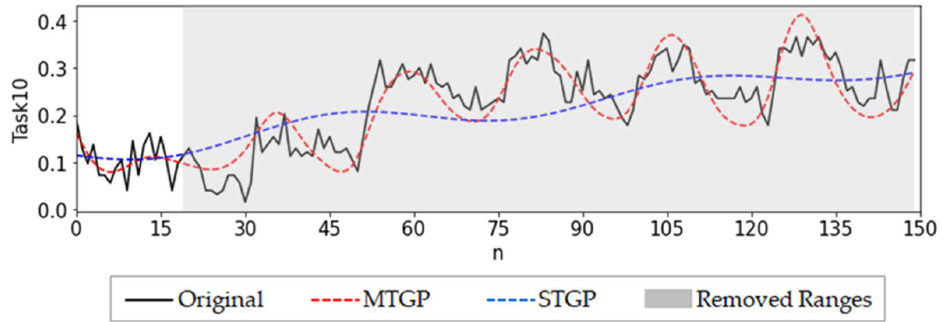
Figure 12. Imputation results of MTGP and STGP for the extreme situation (after normalization).